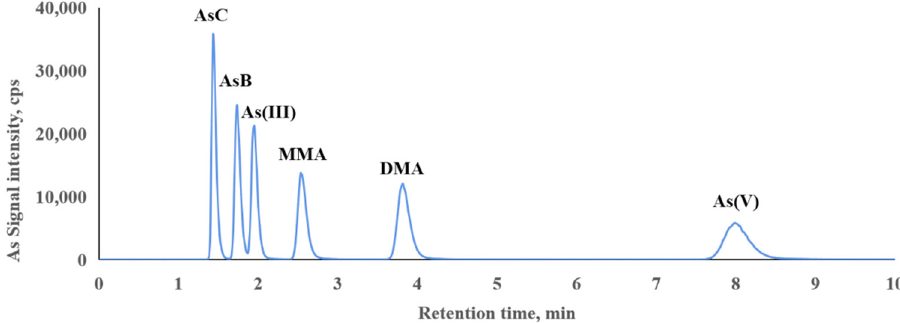
Figure 1. HPLC-ICP-MS chromatogram of a mixture of standards at a concentration of 100 ng g − 1 as As.